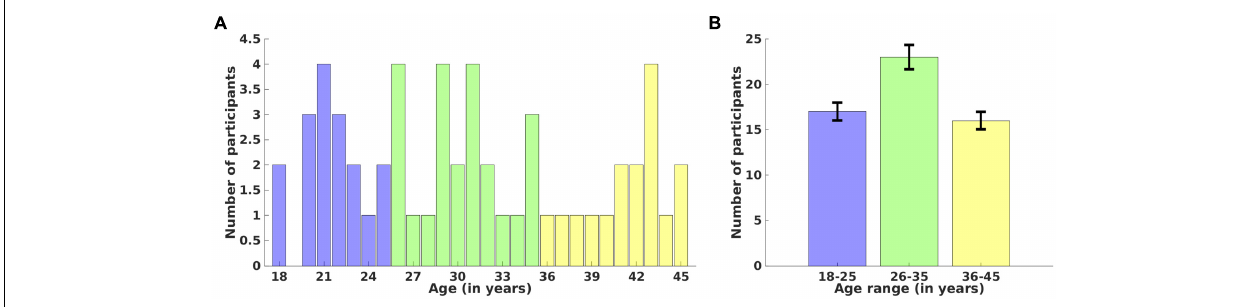
Figure 1 . Participants were screened via a comprehensive telephone interview and were excluded for any history of psychiatric, neurological, or significant medical problems